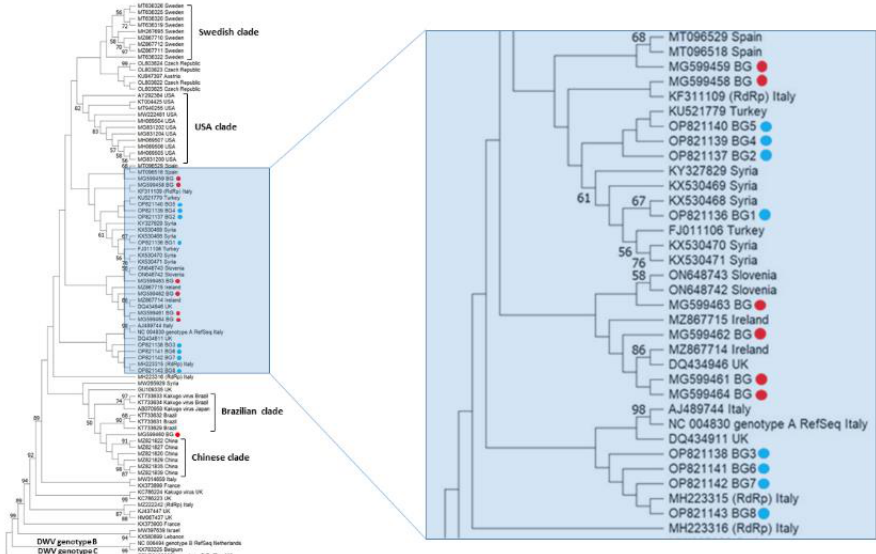
Figure 3. Phylogeny of deformed wing virus (DWV) isolates from Bulgaria and other countries. The unrooted phylogenetic tree was constructed based on the alignment of parts of nonstructural protein gene sequences of DWV isolates (382 bp) (nucleotide positions 8566 bp – 8960 bp according to RefSeq Acc. no. NC_004830) from Bulgaria using the neighbor-joining method under the maximum composite likelihood model. The indicated branching topology was evaluated by bootstrap resampling of the sequences 10,000 times, and nodes supported by bootstrap values > 50 are shown. Each isolate is indicated by the country of isolation and GenBank accession number. Bulgarian iso- lates identified by this study are shown in blue and red (the isolates from honey bees) [48]. Figure 4 represents the phylogeny of Bulgarian SBV isolates from pollen samples.